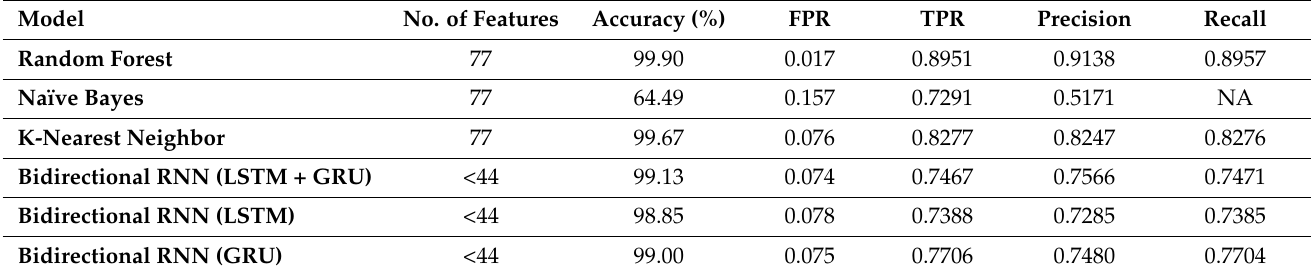
Table 12. Performance of